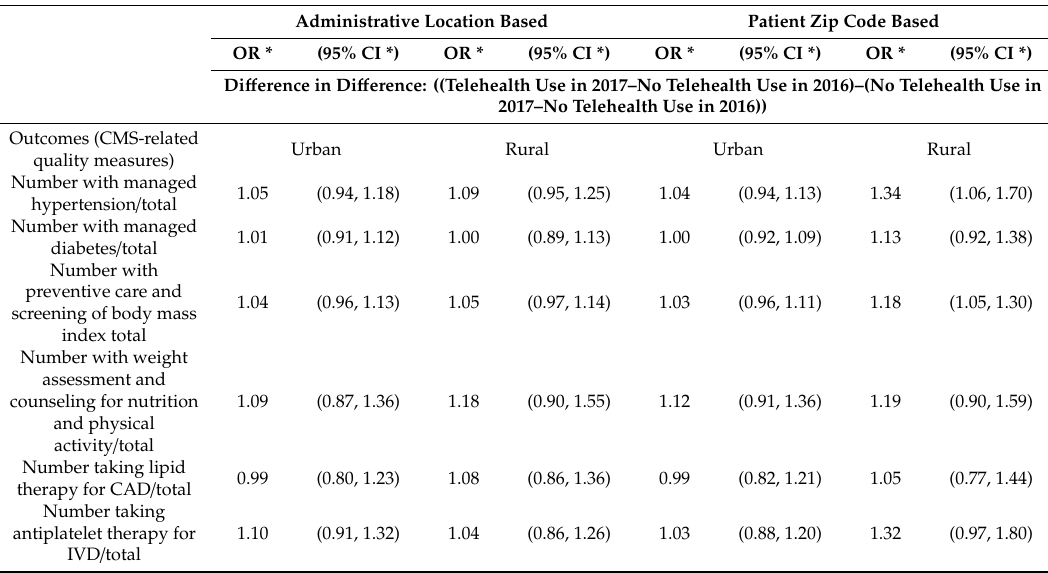
Table 4. Analyzing the associations between telehealth use and the management of cardio-metabolic syndrome-related quality measures stratified by the CHC location, employing the di ff erence in di ff erence approach for the years 2016 and